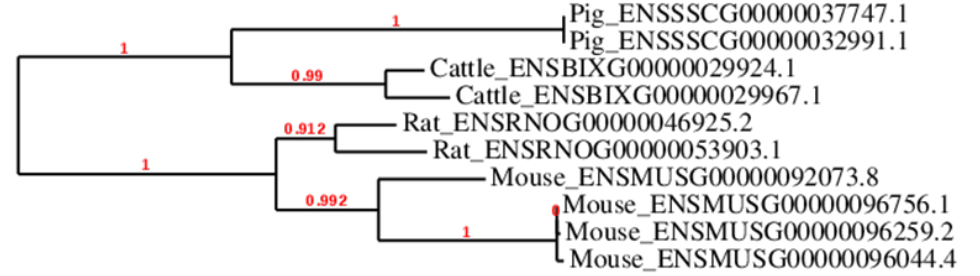
Figure 2. Simplified tree of selected mouse, rat, bovine and porcine oogenesins illustrating the gene duplications that took place after speciation or divergence of these species. Branch lengths correspond to evolutionary distance. Bootstrap values in red indicate the confidence of the node. Other genes have been identified only in a subset of mammalian species, excluding other